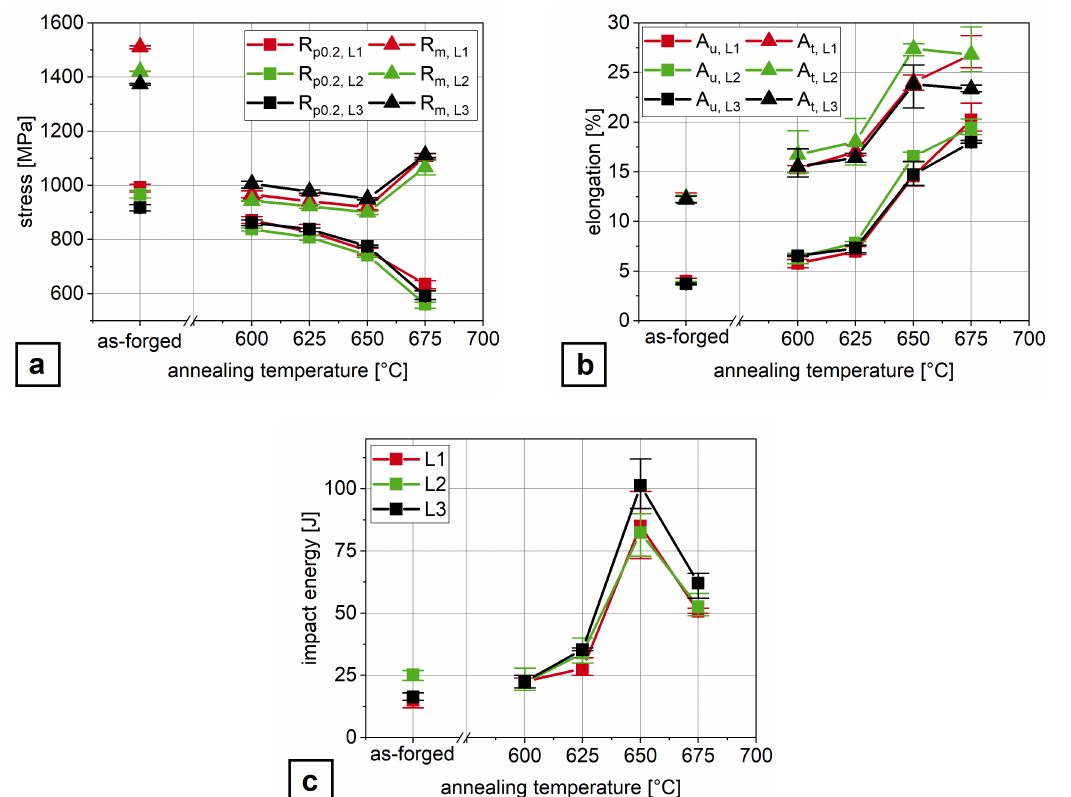
Figure 3. Tempering charts for the alloys L1–L3. The yield strength (YS) and ultimate tensile strength (UTS) ( a ), uniform A u and total elongation A t ( b ) and the impact energy ( c ) are